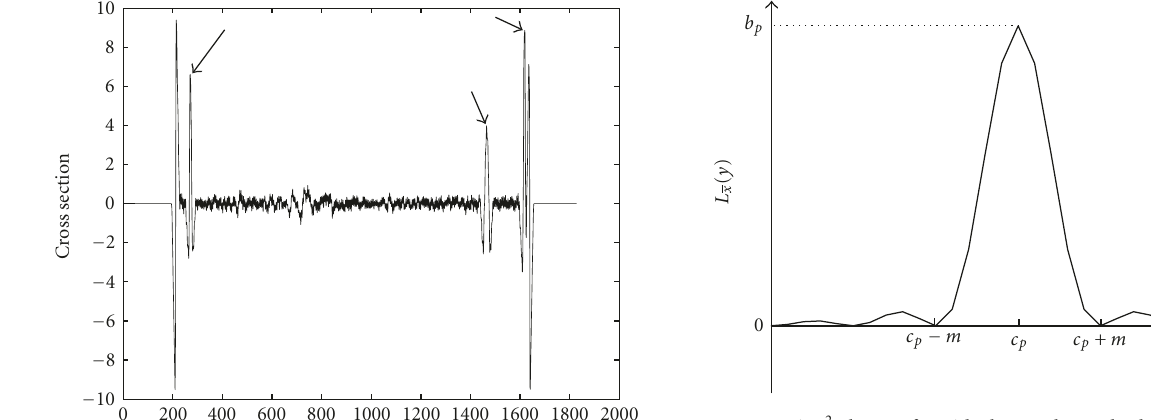
Figure 4: Sinc 2 shape of an ideal scratch on the horizontal cross- section of the degraded image, as in